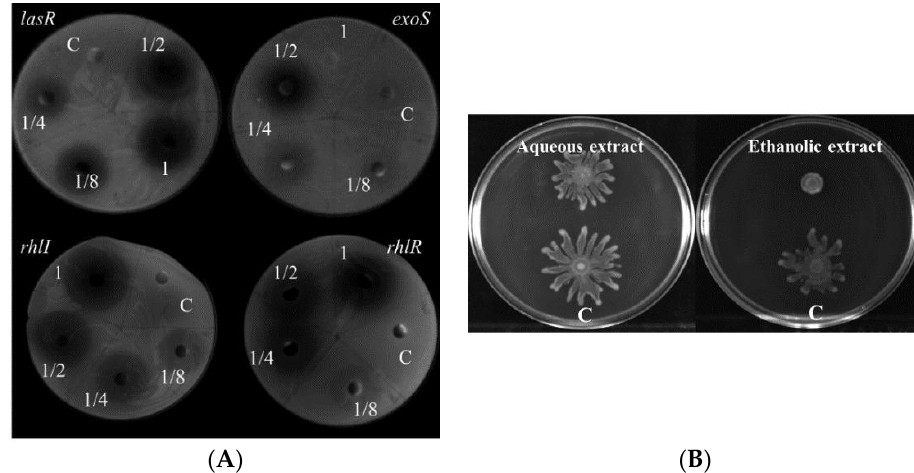
Figure 1. Inhibition of virulence genes expression and swarming motility by the extract of Scutellariae radix . ( A ) Inhibition on the expression of lasR , exoS , rhlI and rhlR by the ethanolic extract of Scutellariae radix . 1, 1/2, 1/4 and 1/8 represent the concentrations of exacts at 172.5 mg/mL, 86.25 mg/mL, 43.13 mg/mL, 21.56 mg/mL respectively; C, solvent as control. ( B ) Inhibition of swarming motility in P. aeruginosa PAO1 by the aqueous and ethanolic extracts. The concentration of extracts was 43.13